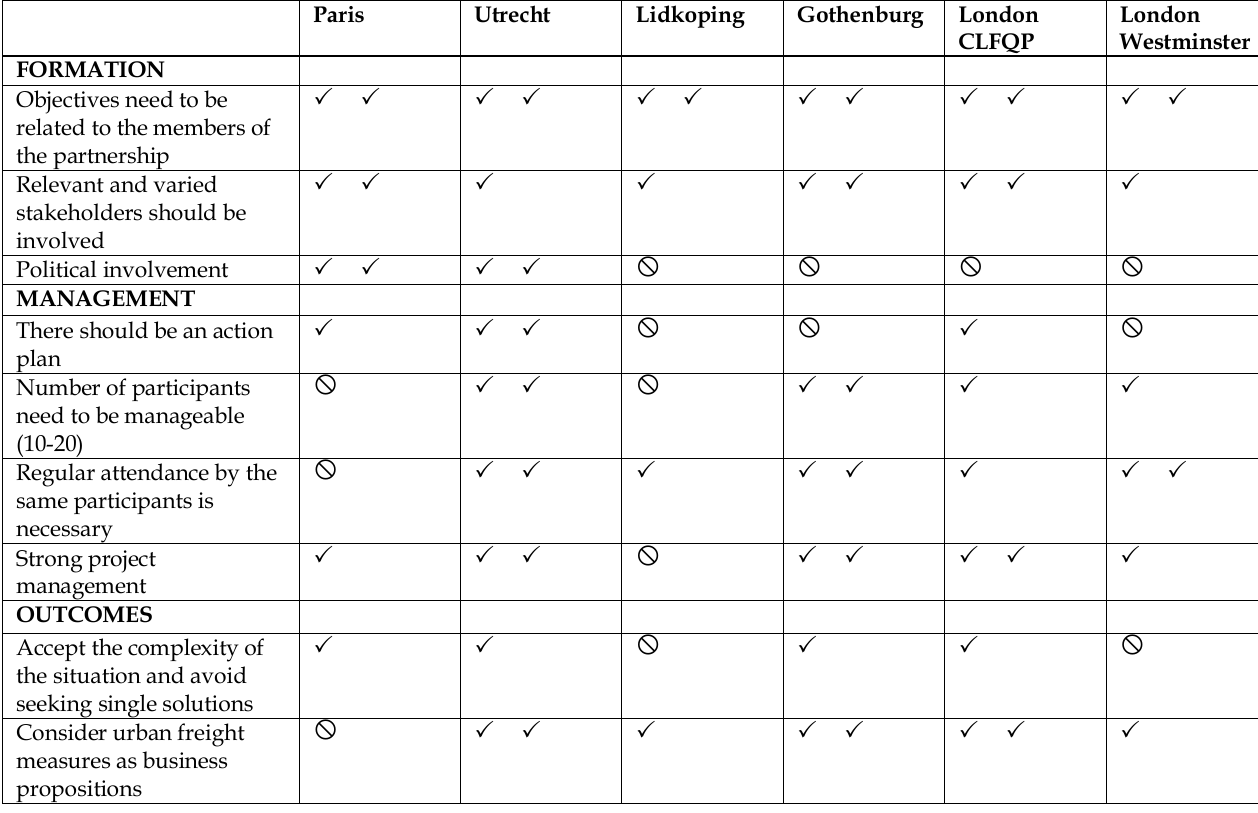
Table 3. Assessment of the partnerships studied according to the nine partnership criteria. Key:  =no evidence was found,  =some evidence,  = strong